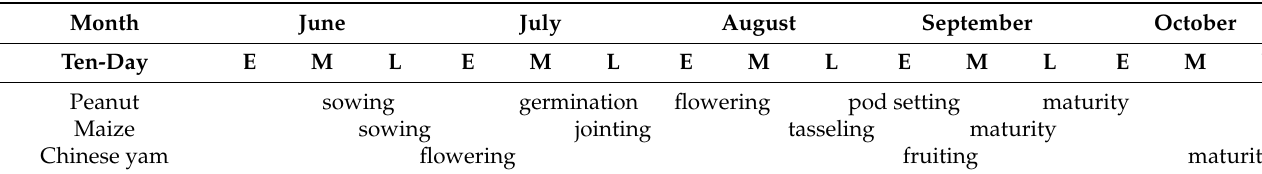
Table 3. Phenological of autumn crops in the study area.